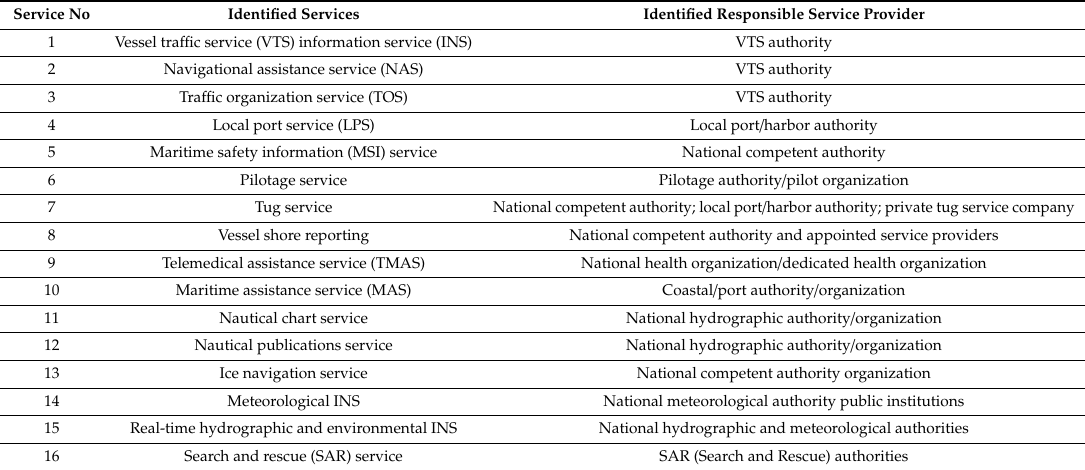
Table 1. Maritime service portfolios with responsible service providers